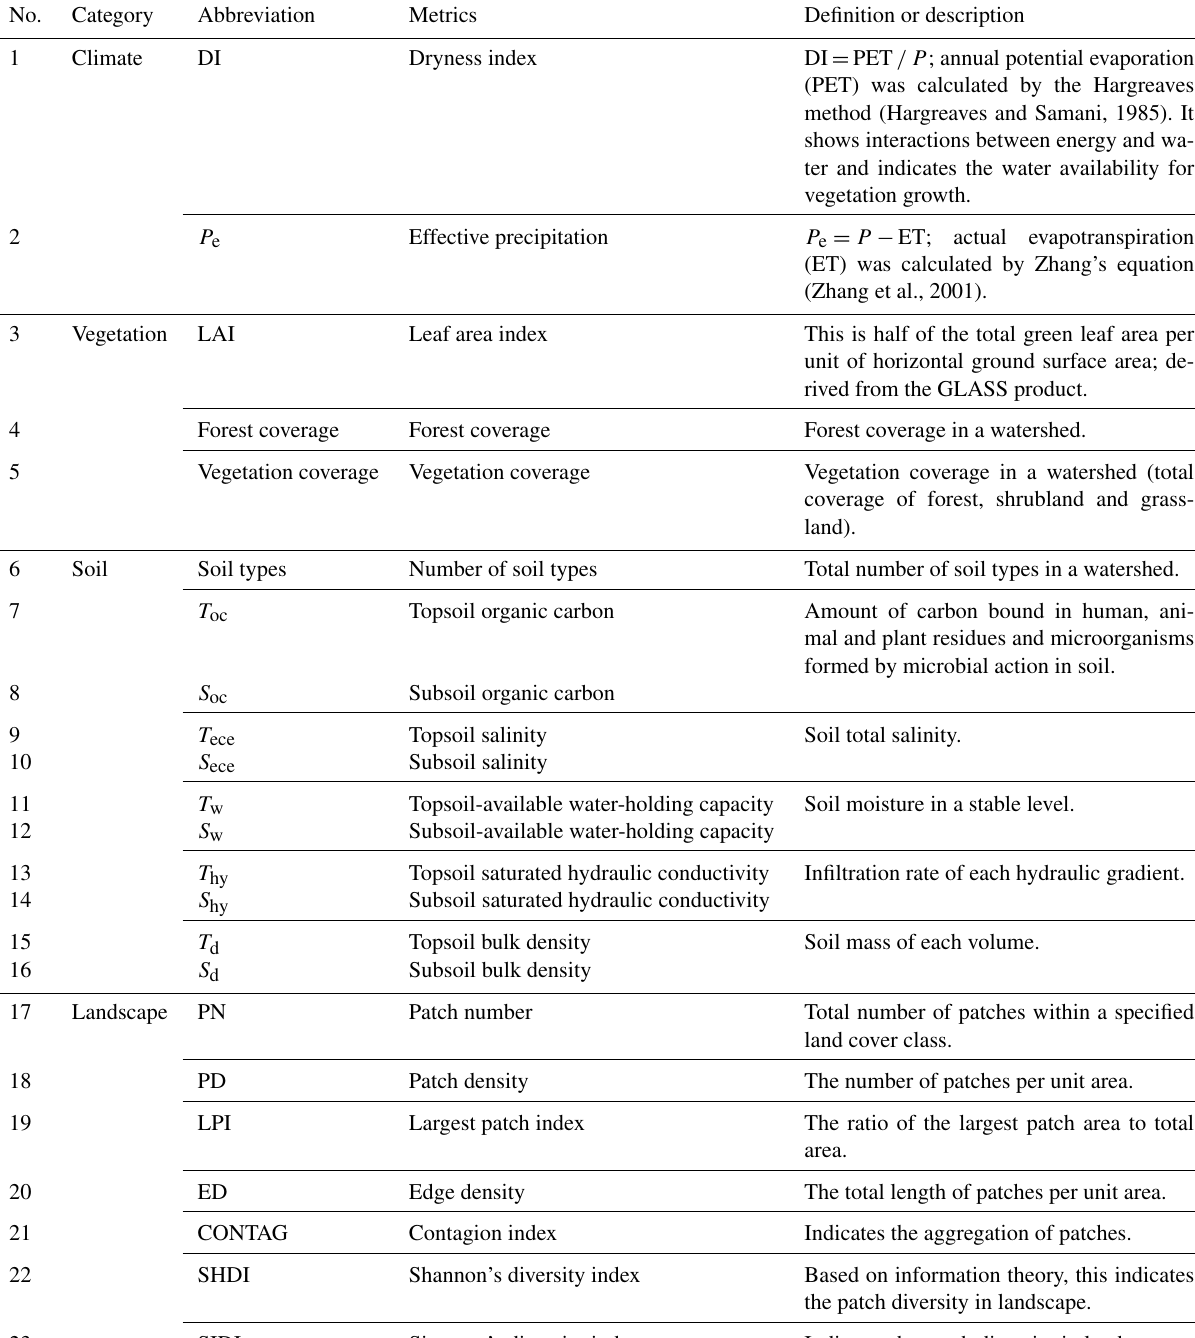
Table 3. Definition or description of the selected influencing